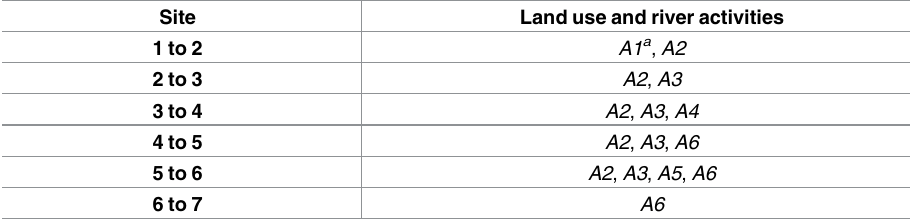
Table 4. Land use and river activities in site transition.